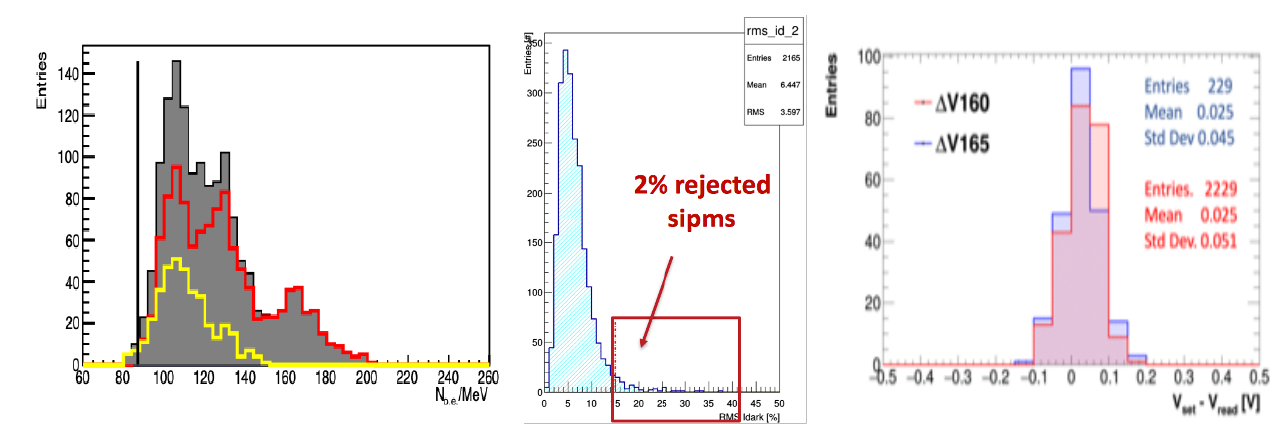
Figure 5. Crystals, SIPMs, and FEE production: ( left ), light yield of crystals (Npe/MeV) as obtained with a large-area PMT fully covering the crystal readout face, the red (yellow) distribution is for the SICCAS (St.Gobain) production crystals; ( center ), RMS of Idark (%) of each SiPM array; ( right ), precision of HV settings for the FEE